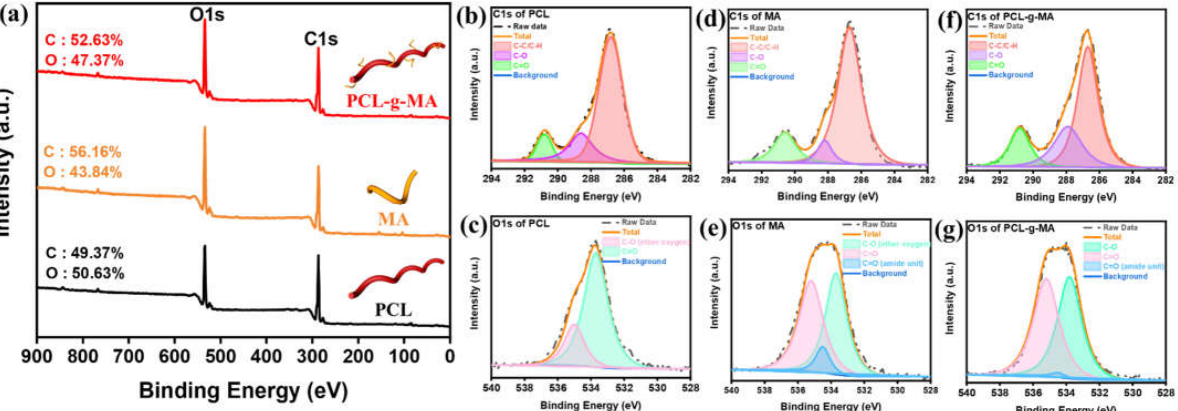
Figure 2. ( a ) XPS full spectra of PCL, MA and PCL-g-MA, and high-resolution XPS spectra of ( b ) C 1s of PCL, ( c ) O 1s of PCL, ( d ) C 1s of MA, ( e ) O 1s of MA, ( f ) C 1s of PCL-g-MA and ( g ) O 1s of PCL-g-MA prepared by 3.375 g PCL, 3.000 g MA and 1.120 g DBPO by 18 h.